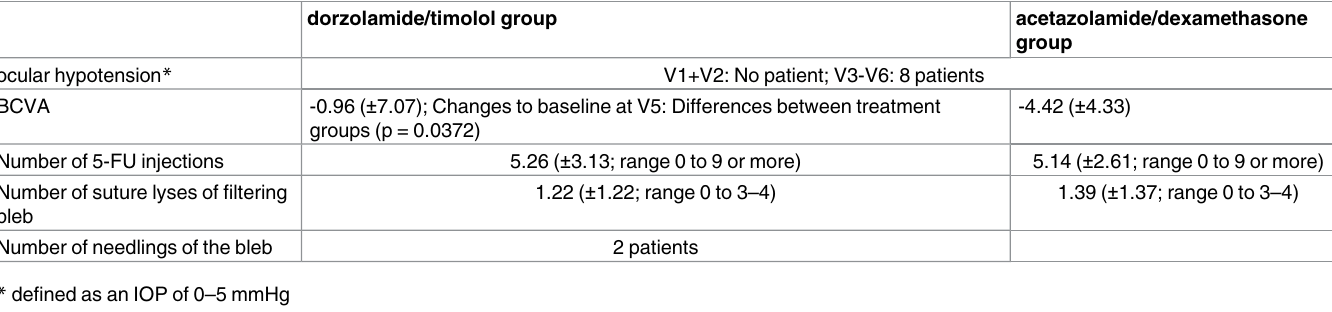
Table 5. Postoperative complications and